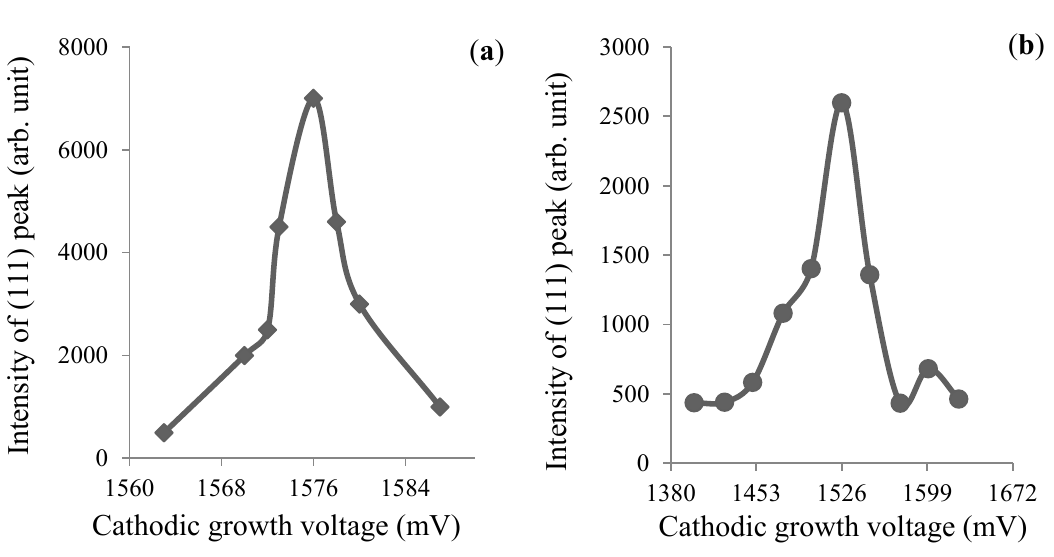
Figure 3. Intensity of (111) peak as a function of growth voltage for ( a ) pH = 2.00 and ( b ) pH = 1.44. The growth of stoichiometric CdTe is shown at 1.576 V and 1.526 V at the two different pH values for the samples showing highest crystallinity.